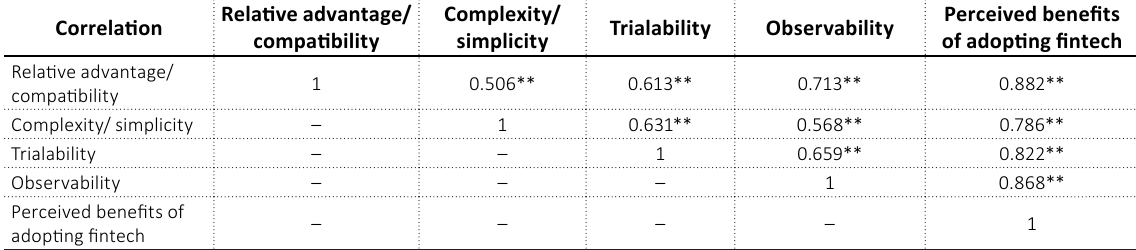
Table 6. Correlation matrix